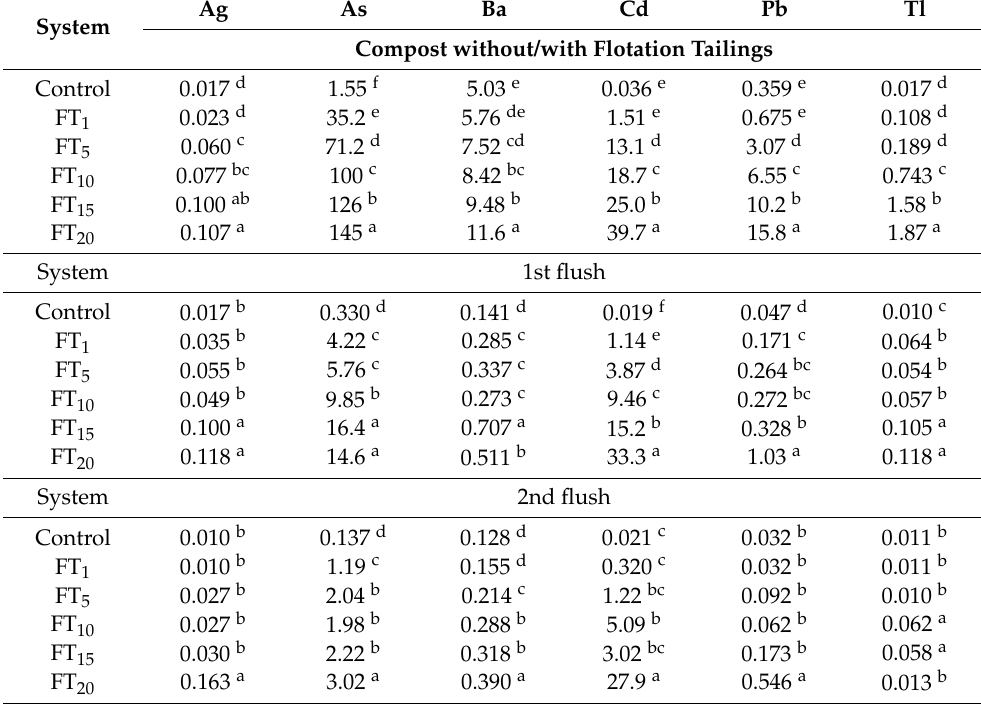
Table 4. Content of trace elements with detrimental health effects [mg kg − 1 dry weight] in compost with flotation tailings before the experiment and fruit bodies from particular flushes. Ag As Ba Cd System Compost without/with Flotation